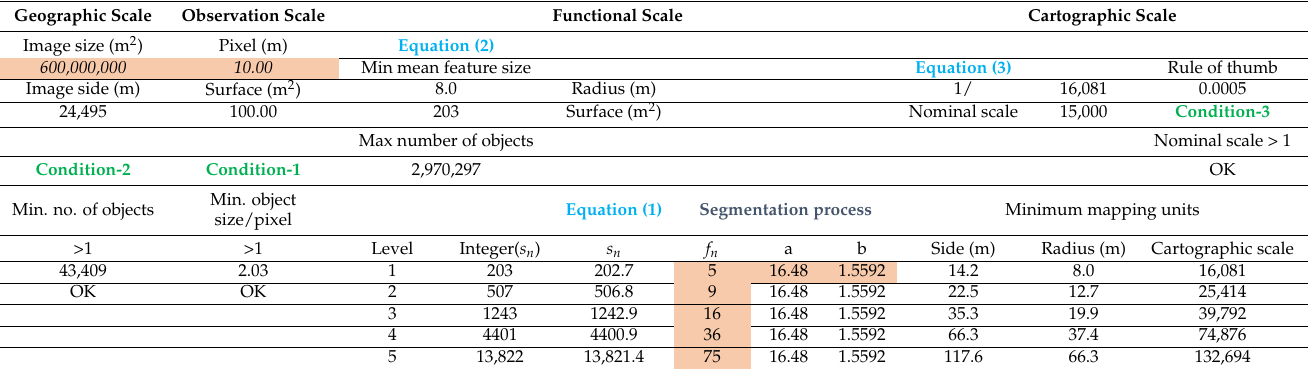
Table 2. The scale calculator for the Sentinel-2 image subset and conditions running for Level-1 segmentation (data from Karydas